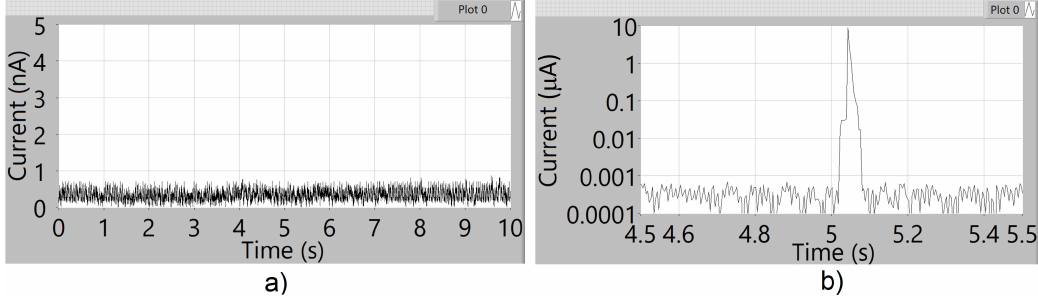
Figure 12. Current in GEM TOP 2. ( a ) Current in the stable state. ( b ) Current with a discharge, the plot shows the current in logarithmic